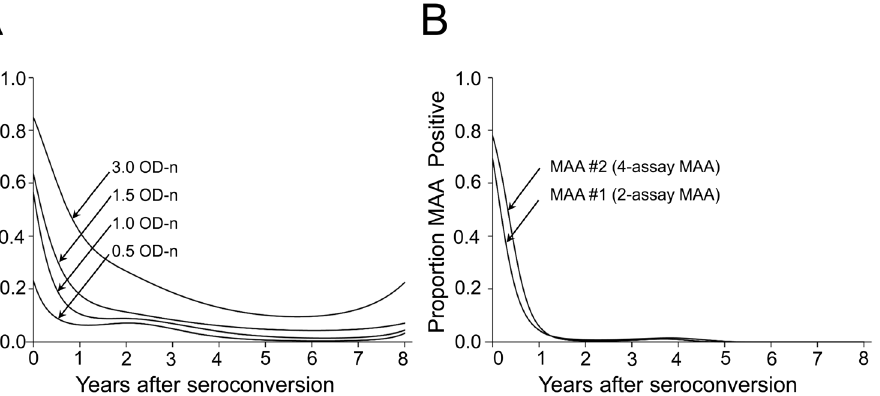
Figure 1. Proportion of samples classified as assay positive using the LAg-Avidity assay alone or with HIV viral load, as a function of the duration of HIV infection. Probability curves were generated by analyzing samples from three cohort studies (see Methods). (A) Probability curves generated using the LAg-Avidity assay with four different assay cutoffs (0.5, 1.0, 1.5, and 3.0 normalized optical density units [OD-n]). Samples were classified as assay positive if the LAg-Avidity assay result was below the assay cutoff. (B) Probability curves generated using the MAAs shown in Figure 2. Samples were classified as MAA positive if results from each of the component assays met the requirements of the MAA. doi:10.1371/journal.pone.0082772.g001 PLOS ONE |